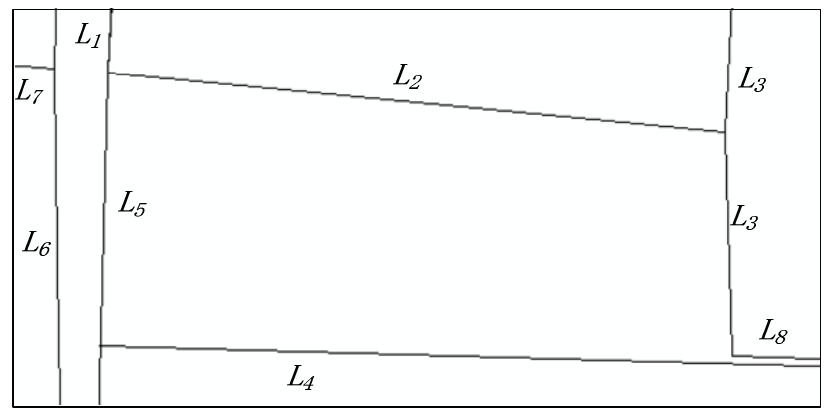
Figure 21. Examples of topological conflict dealing results between lines.